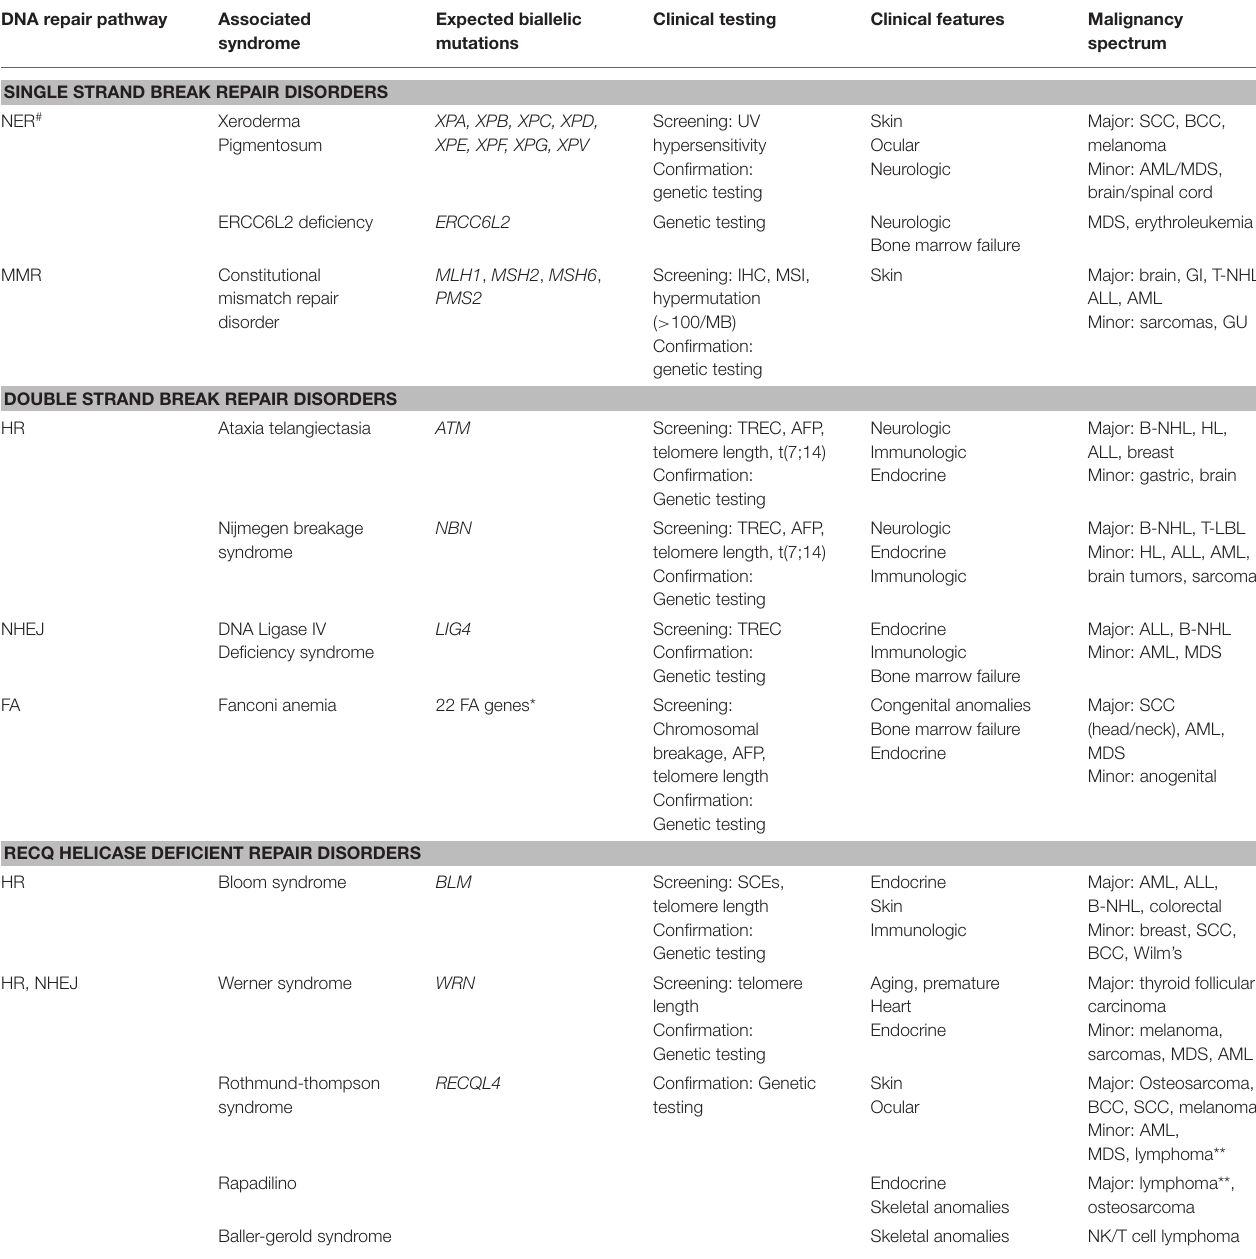
TABLE 1 | DNA repair deficiencies in single strand and double strand DNA repair and RECQ helicases result in classic DNA repair syndromes with multisystemic manifestations and oncogenic predisposition. DNA repair